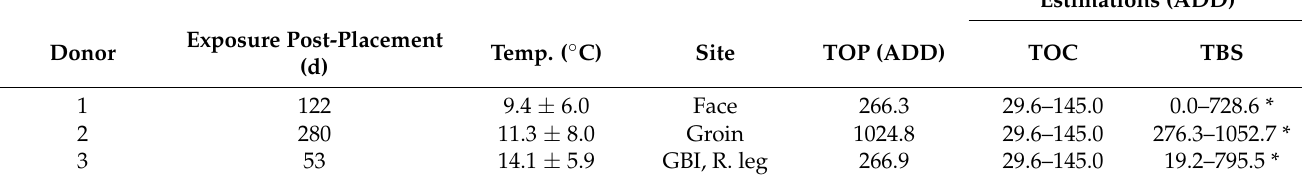
Table 2. Summary of third instar larval Phormia regina sampled on the first collection day from Donor 1 and from the last collections days for Donors 2 and 3. The total exposure time from placement to the sampling of third instar P. regina is given in days (d) for each donor. The 15 ◦ C dataset from the Byrd and Allen (2001) developmental study was used to determine the time of colonization (TOC) estimation range. Temperature = mean ± standard deviation for exposure period given in ◦ C. Site = larval sampling location on or around each donor (GBI = ground-body interface). TOP is given as the total ADD acquired during the exposure period. All TOC and total body score (TBS) estimation ranges are given in ADD utilizing a base temperature of 10 ◦ C. * = accurate estimation.